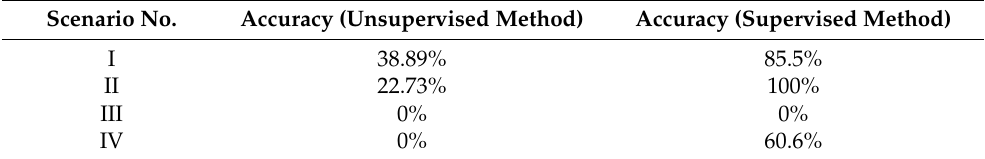
Table 3. Table of detection